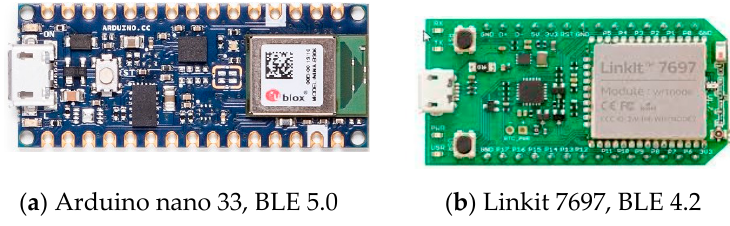
Figure 2. The appearance of Arduino nano 33 and Linkit 7697.